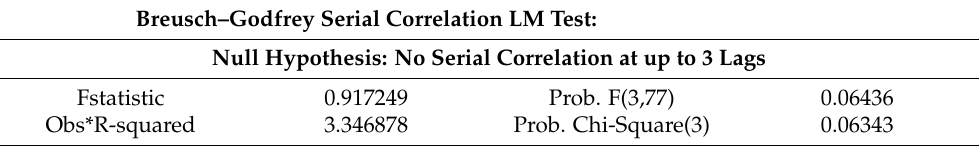
Table 3. Breusch–Godfrey serial correlation LM test (Lag 3–Year